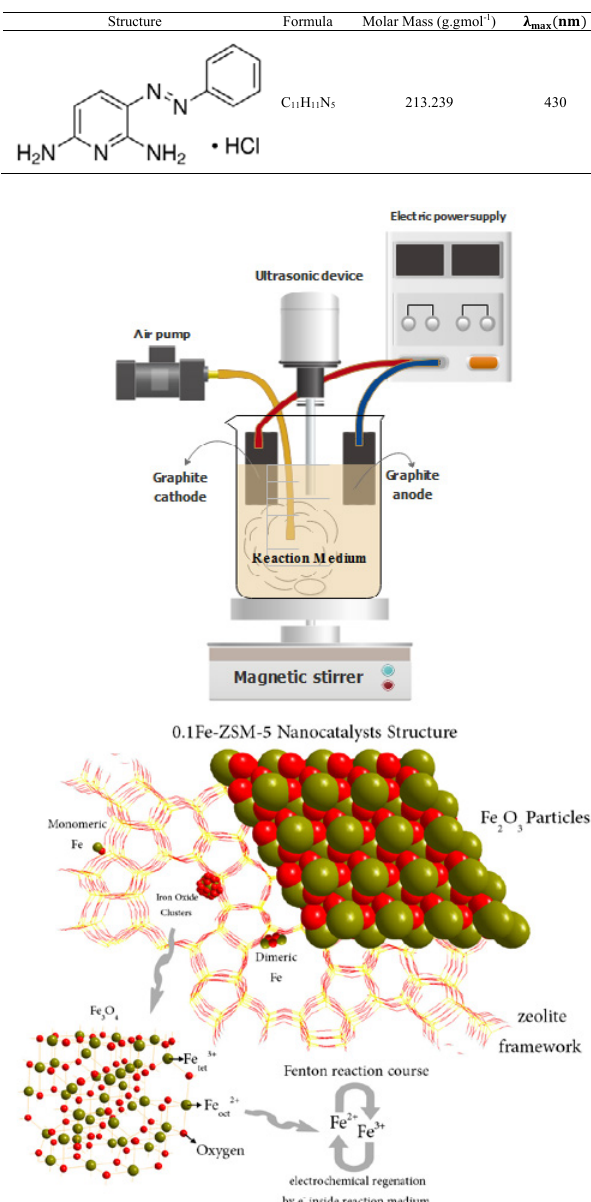
Table 1. General information of PHP